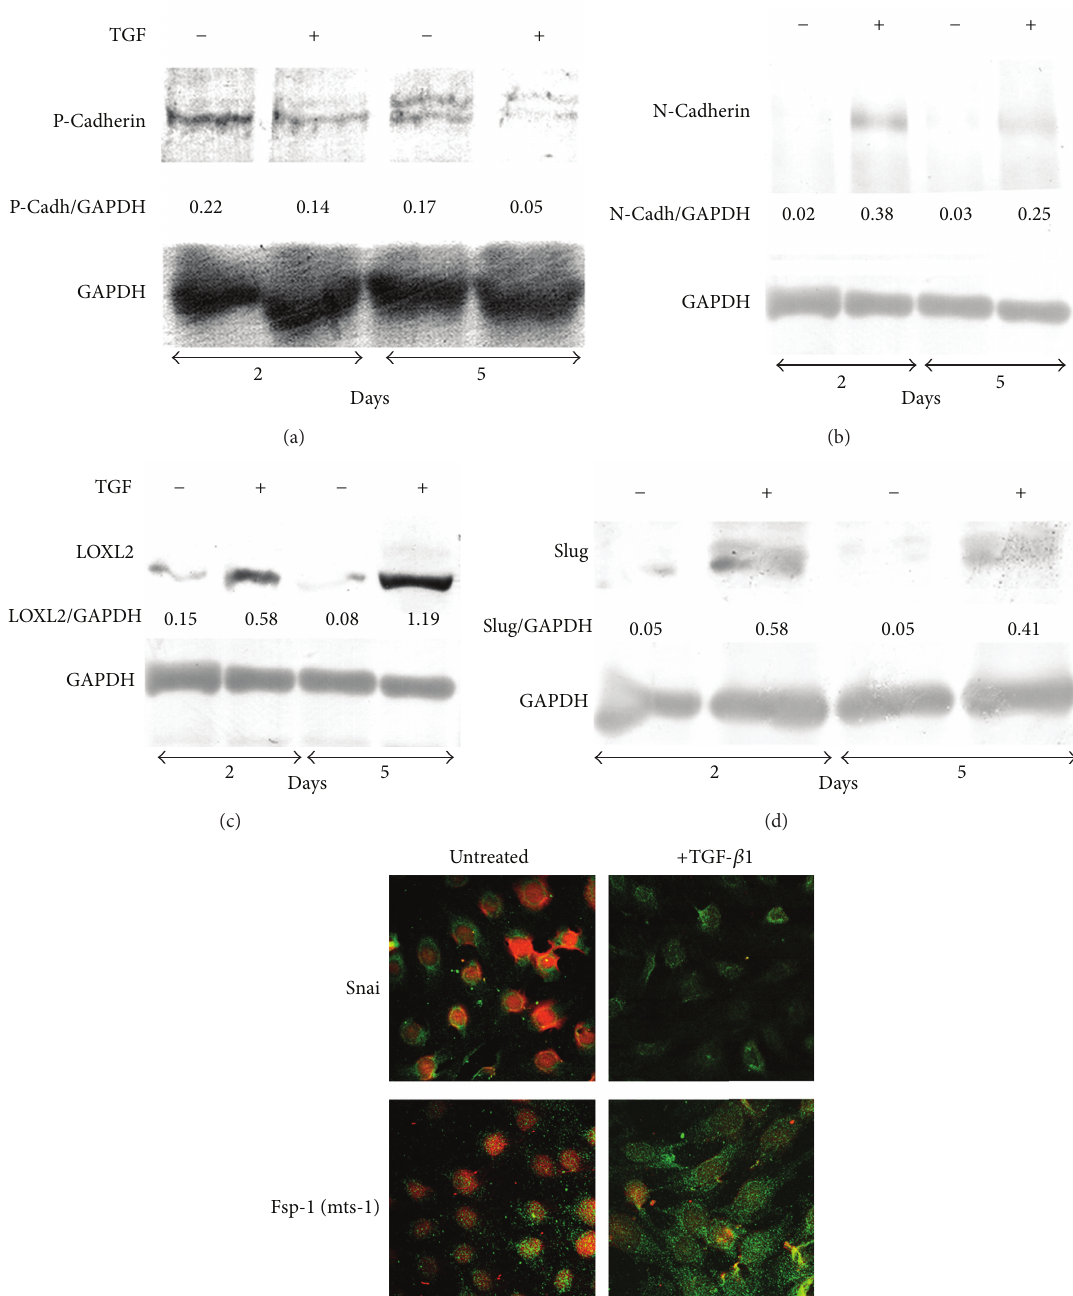
Figure 2: Analysis of additional EMT marker expressions in wild type human podocytes, upon TGF- 𝛽 1 treatment. The cells were treated as indicated in Figure 1. (a) The rabbit anti-P-cadherin (sc-7893), (b) N-cadherin (sc-7939), (d) anti-Slug (sc-15321) and polyclonal antibodies were purchased from Santa Cruz Biotechnologies (Santa Cruz, CA, USA). (c) The rabbit anti-LOXL2 (A01) was purchased from Abnova (Taiwan). To quantify the protein bands, we scanned the blots and performed a densitometry analysis, using the software NIH ImageJ v. 6.4 (freeware, NIH, MD, USA). (e) Confocal laser scanned immunofluorescence of Snail-1 and Fsp-1 expressions. The cells were treated as indicated and prepared for immunofluorescence analysis as described in Section 2. The goat anti-Snail-1 (sc-10433) and anti-Fsp1 (also known as Mts-1) (sc-19949) antibodies were purchased from Santa Cruz Biotechnologies, (Santa Cruz, CA, USA). The secondary antibodies were conjugated with Alexa Fluor 488 dye (Molecular Probes, Eugene, OR, USA). Nuclei were previously stained with propidium iodide. The figure shows a typical experiment of at least three performed under the same